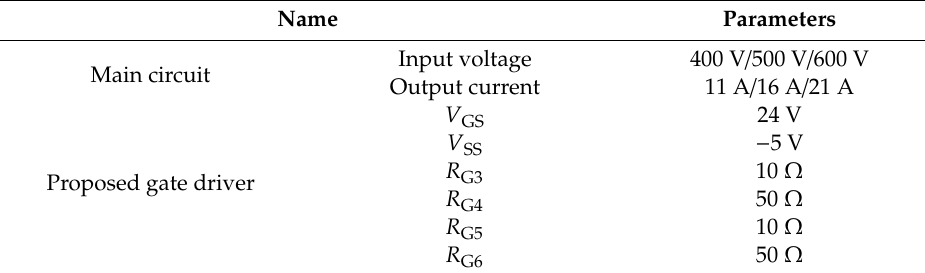
Table 2. Driving parameters of the proposed gate diver.